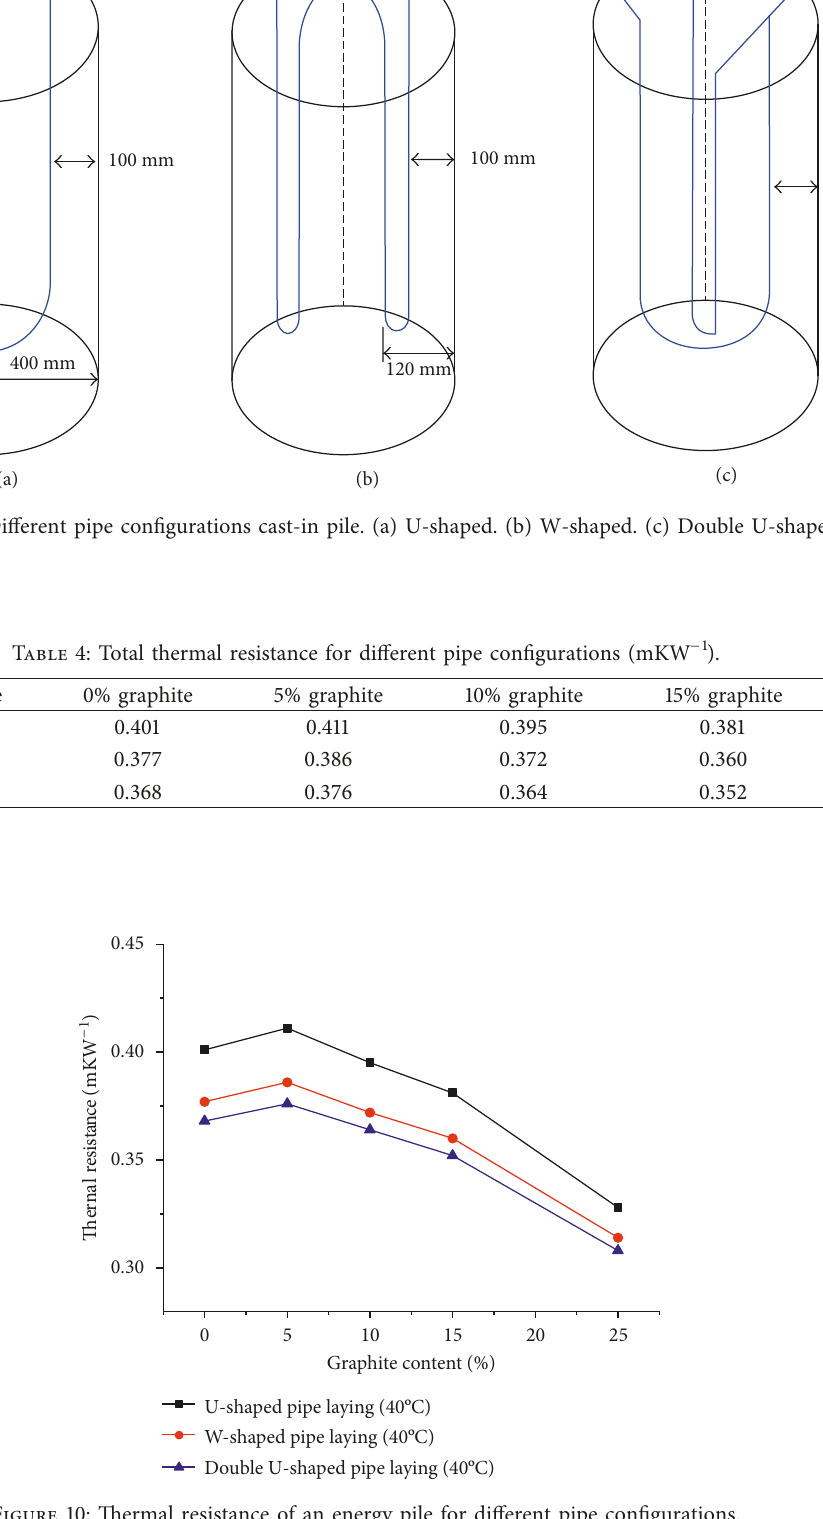
Figure 10: Thermal resistance of an energy pile for different pipe